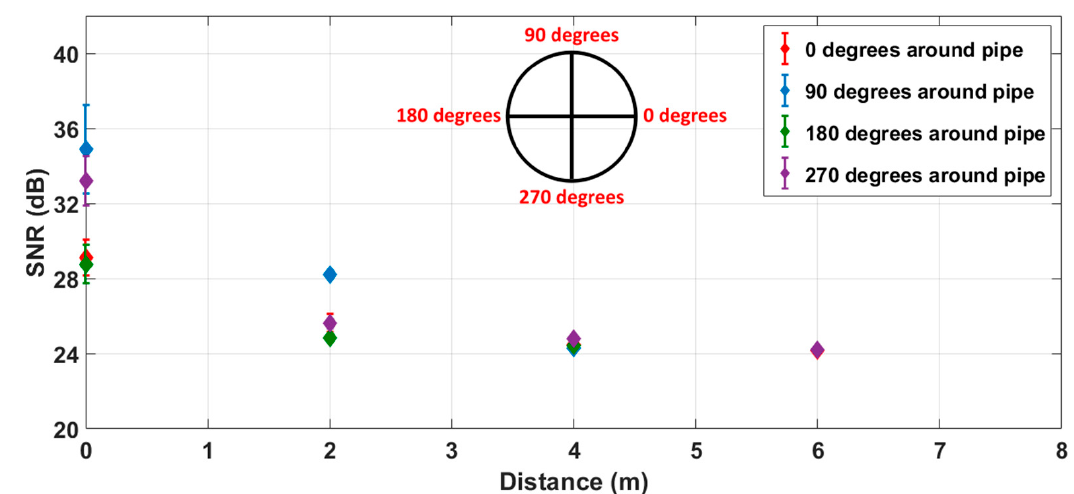
Figure 7. SNR (dB) of the measured acoustic signals at the four circumferential locations and at increasing distances along the exposed (empty) MDPE pipe.